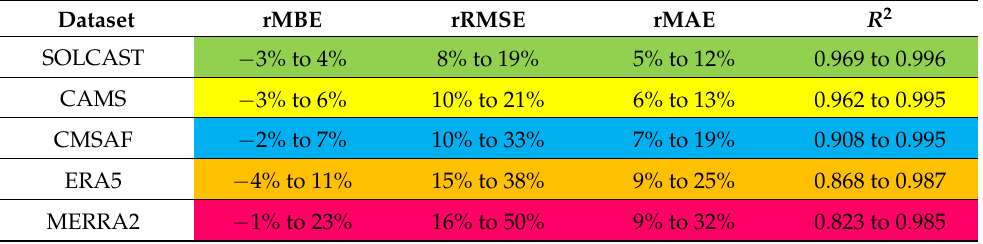
Table 8. Summary of the overall validation results. Colors are used to show the overall performance ranking of the five datasets with green (1/5), yellow (2/5), blue (3/5), orange (4/5), and red (5/5). Dataset rMBE rRMSE rMAE R 2 SOLCAST − 3% to 4% 8% to 19% 5% to 12% 0.969 to 0.996 CAMS − 3% to